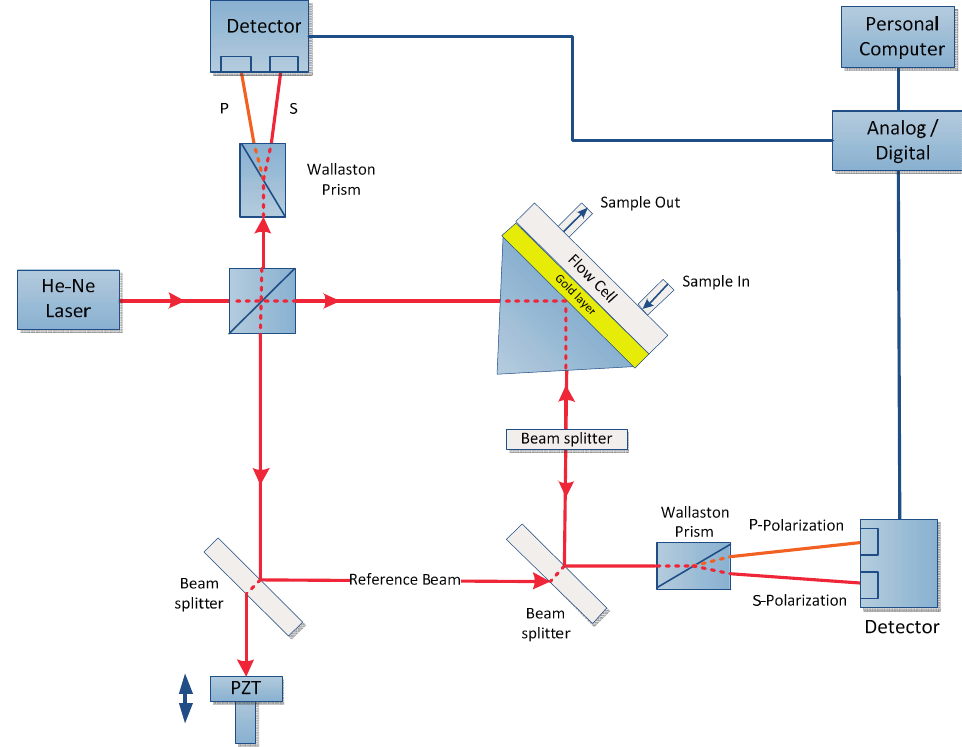
Figure 6. Experimental setup containing Mach-Zehnder and Michelson interferometers used to measure differential phase